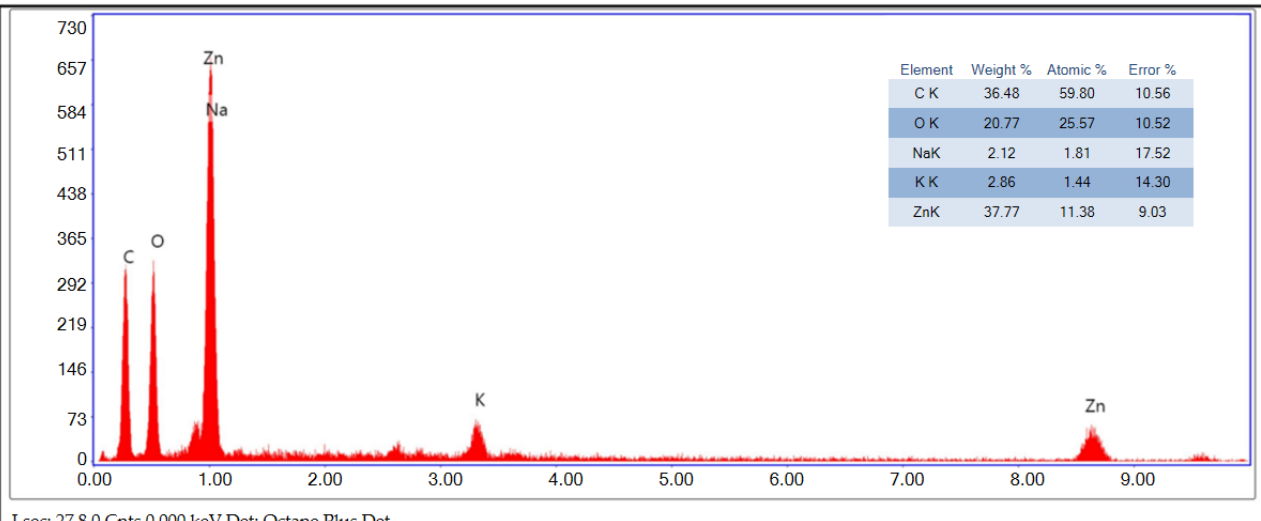
Figure 4. UV-Vis spectrum of Zinc oxide nanoparticles with Tauc’s plot in the inset showing energy band gap intercept at 3 eV. When zinc nitrate hexahydrate is added to the aqueous extract of the Acacia caesia bark and heated, the formation of yellow colour serves as a visual confirmation on the formation of compounds of zinc nanoparticle [16,74]. This may also be due to the for- mation of Zinc oxide from Zinc nitrate hexahydrate using the secondary metabolites pre- sent in the plant extract as reported in the past. The change of colour to yellow may be attributed to oxygen deficiencies as Zinc oxide nanoparticles are heated ZnO = Zn 2 + + ½ O 2 + 2e −